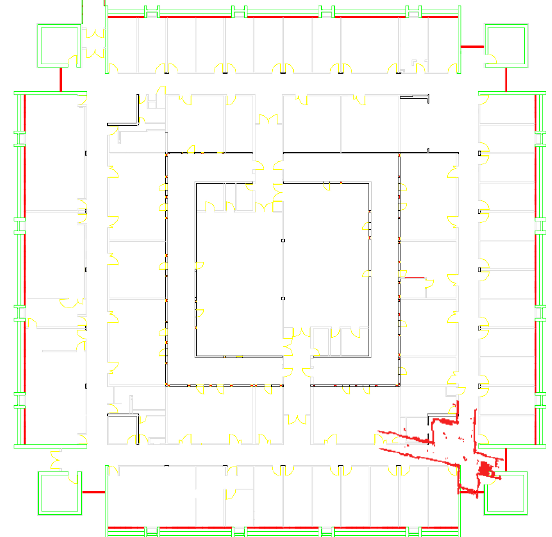
Figure 9. Overlay of the registered PC on the CAD using the manual